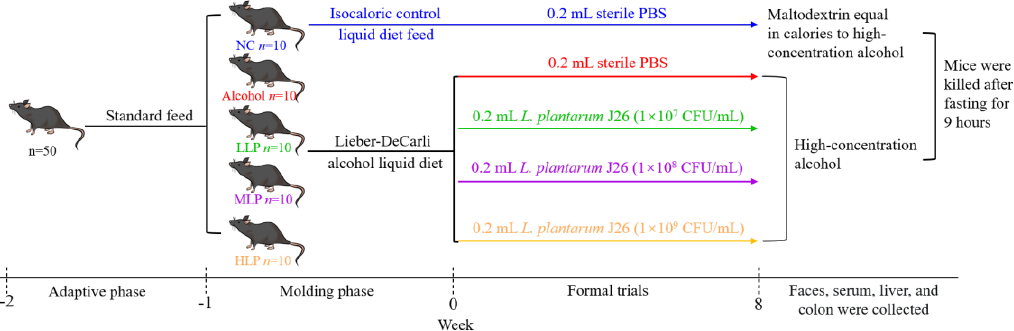
Figure 1. Scheme of animal experiment. NC, normal control; LLP, low-dose L. plantarum J26; MLP, medium-dose L. plantarum J26; HLP, high-dose L. plantarum J26.